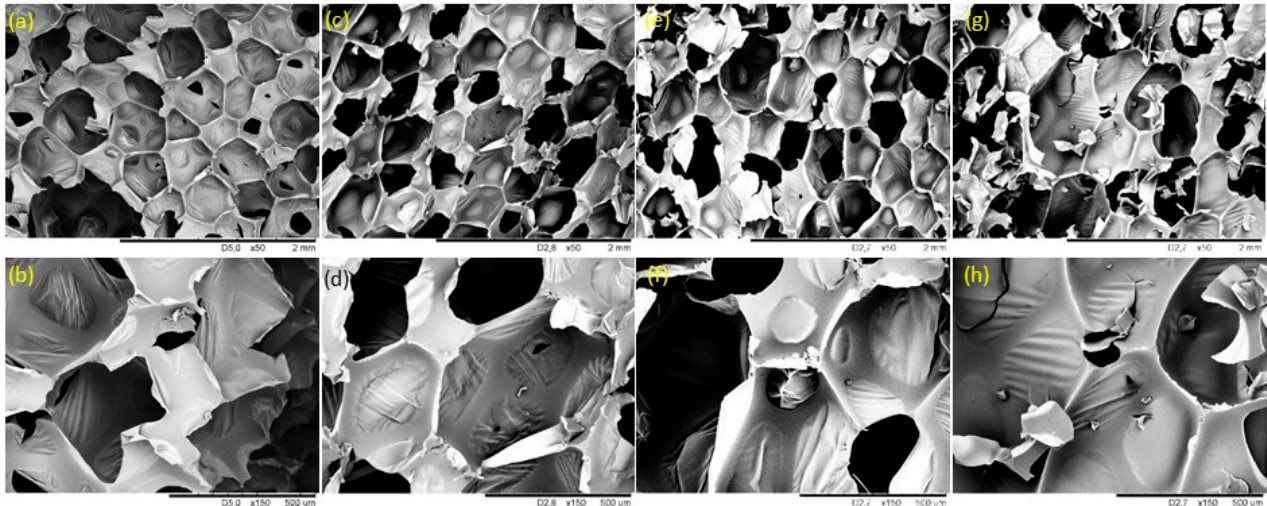
Figure 2. SEM images of the studied RPUF composites: ( a , b ) Neat RPUF; ( c , d ) CF 0.1; ( e , f ) CF 0.5; ( g , h ) CF 1.